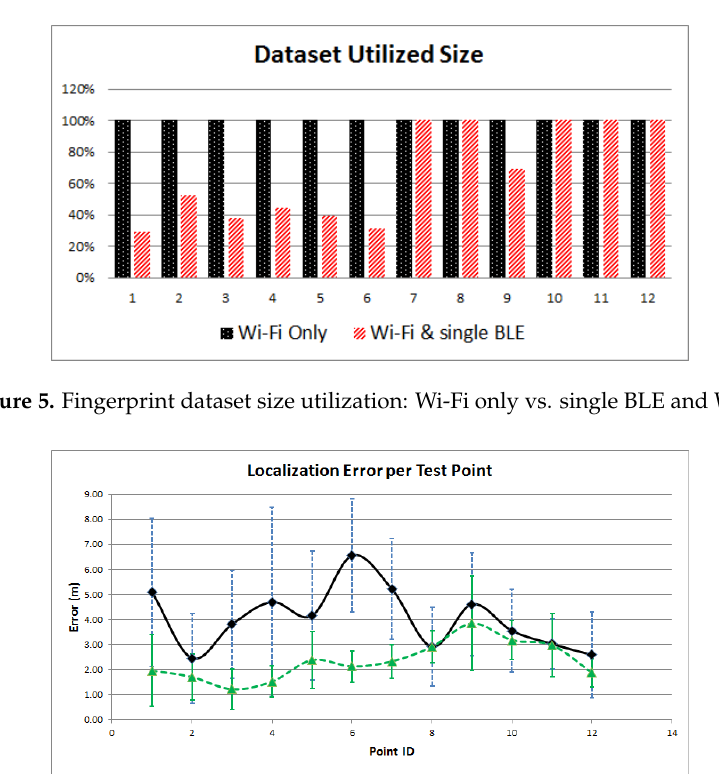
Figure 4. Positioning error comparison: Wi-Fi only vs. single BLE and Wi-Fi.